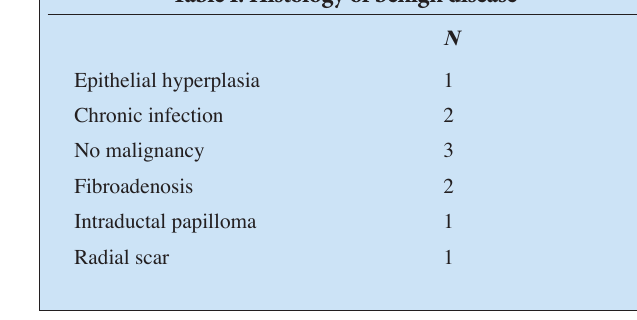
Table I. Histology of benign disease